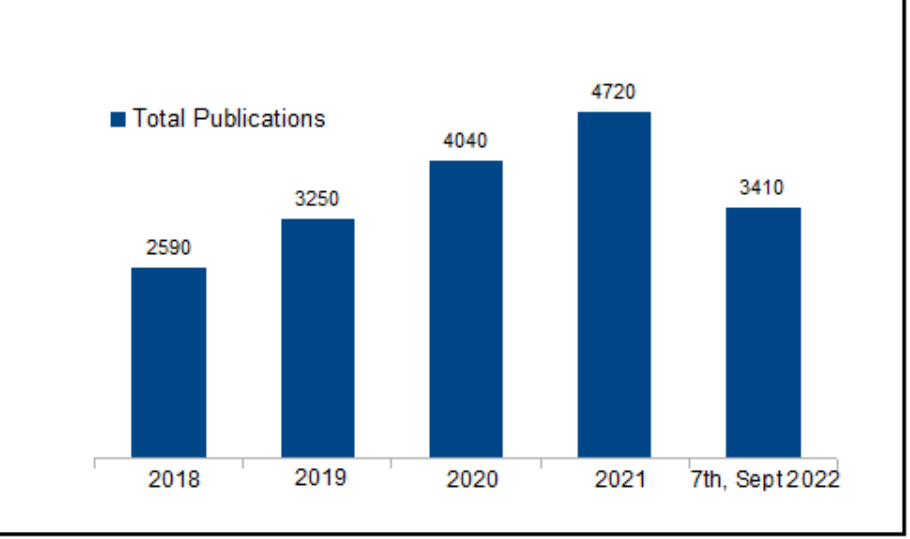
Figure 3. Year-wise publications with the search string “smart grid” AND “cyber threats” OR “cyberattacks” OR “vulnerabilities” on Google